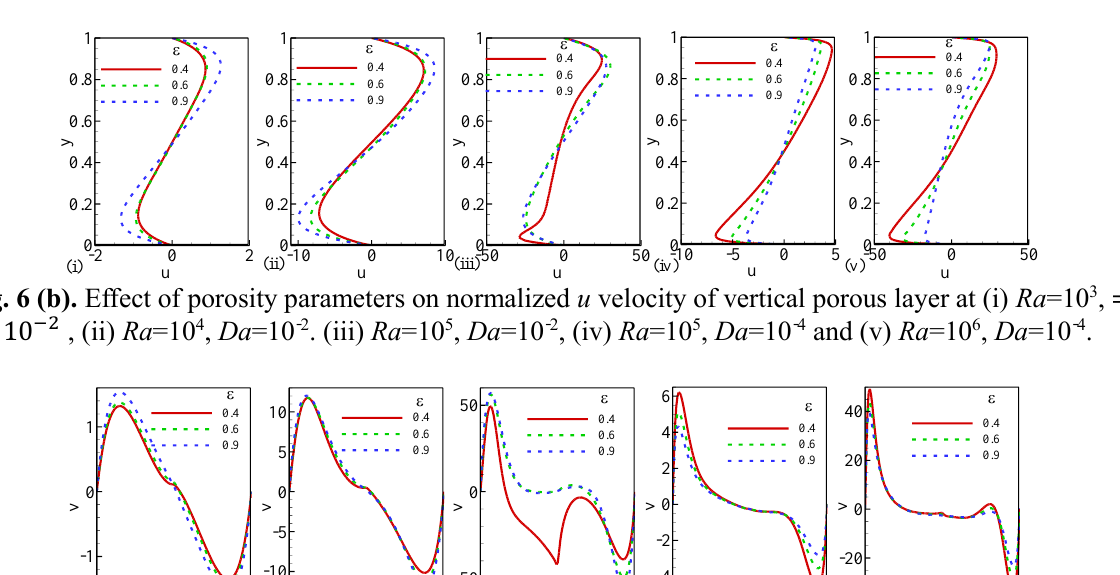
Fig. 6 (a). Effect of porosity parameters on normalized u velocity of horizontal porous layer at (i) Ra =10 3 , Da =10 -2 , (ii) Ra =10 4 , Da =10 -2 . (iii) Ra =10 5 , Da =10 -2 , (iv) Ra =10 5 , Da =10 -4 and (v) Ra =10 6 , Da =10 -4 .